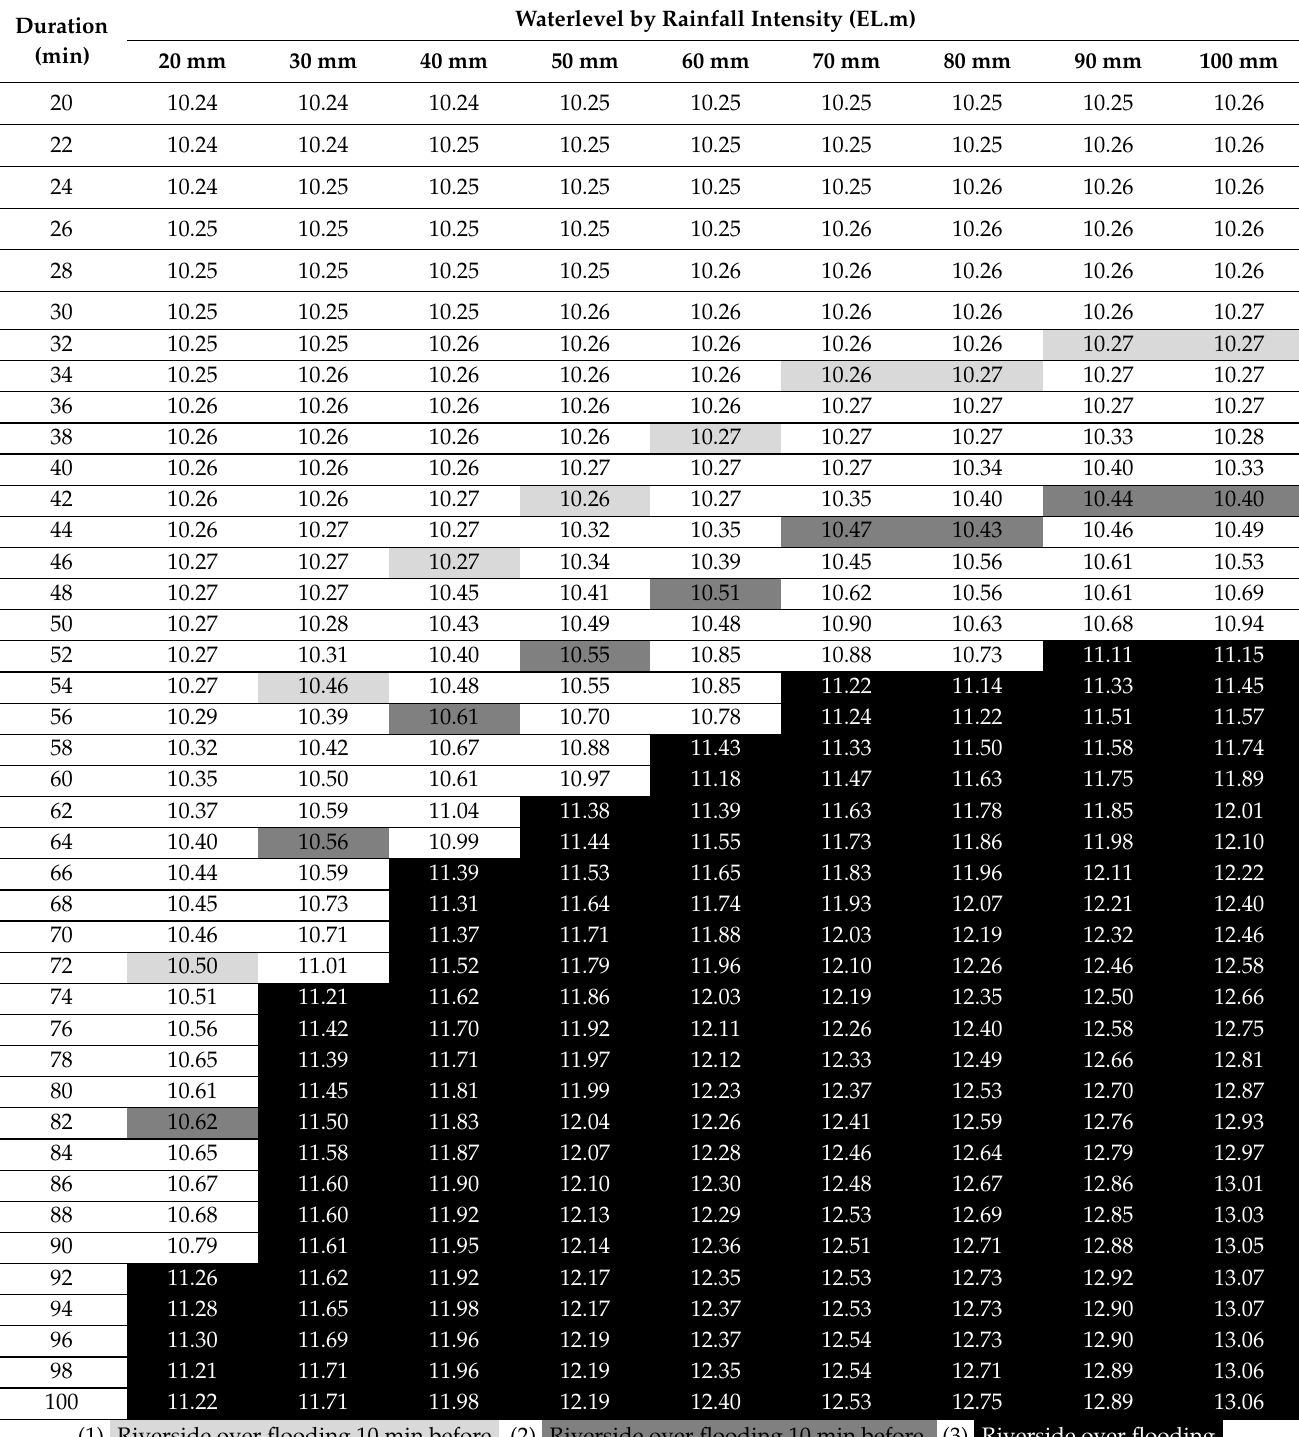
Table 2. Waterlevel analysis due to rainfall scenario in Dorim basin (Guro digital